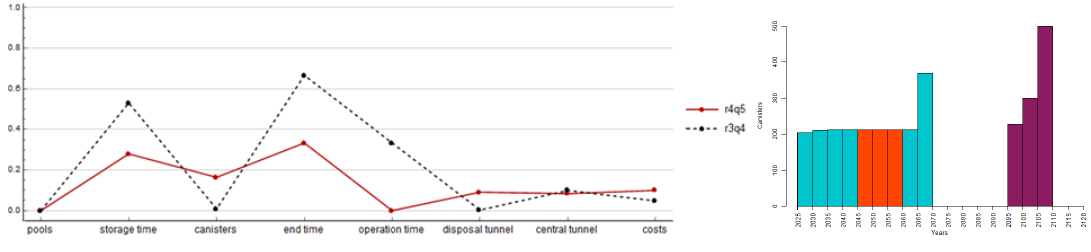
Figure 8. Result having increasing production.